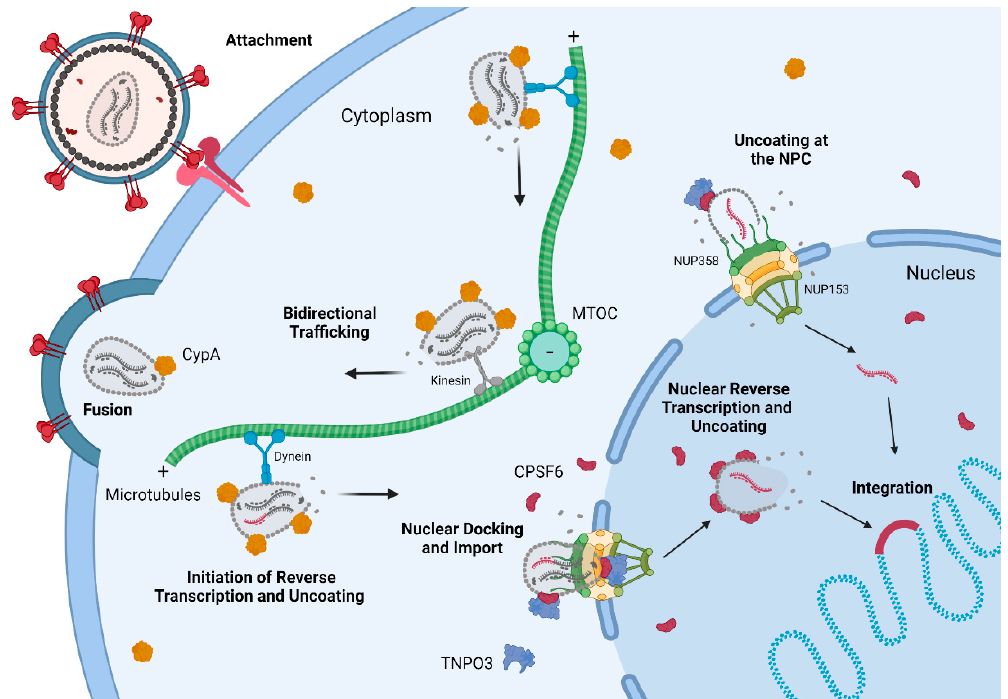
Figure 1. Overview of early HIV-1 replication. HIV-1 attaches to the CD4 receptor and chemokine co-receptor before fusing with the cell membrane, releasing the capsid into the cytoplasm where host factors bind the capsid surface and capsid uncoating may initiate. Dynein and kinesin facilitate bidirectional movement of the HIV-1 capsid on microtubules. Near the nucleus, the capsid is bound by CPSF6 and TNPO3. Engagement with the NPC allows capsid docking and eventual nuclear import. In the nucleus, reverse transcription and capsid uncoating are completed near the site of integration. CypA, cyclophilin A; MTOC, microtubule organizing center; TNPO3, transportin 3; CPSF6, cleavage and polyadenylation factor 6; NPC, nuclear pore complex. Created using BioRender.